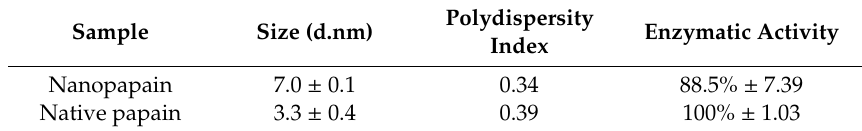
Table 1. Sizes measured by dynamic light scattering (DLS) and proteolytic activity.